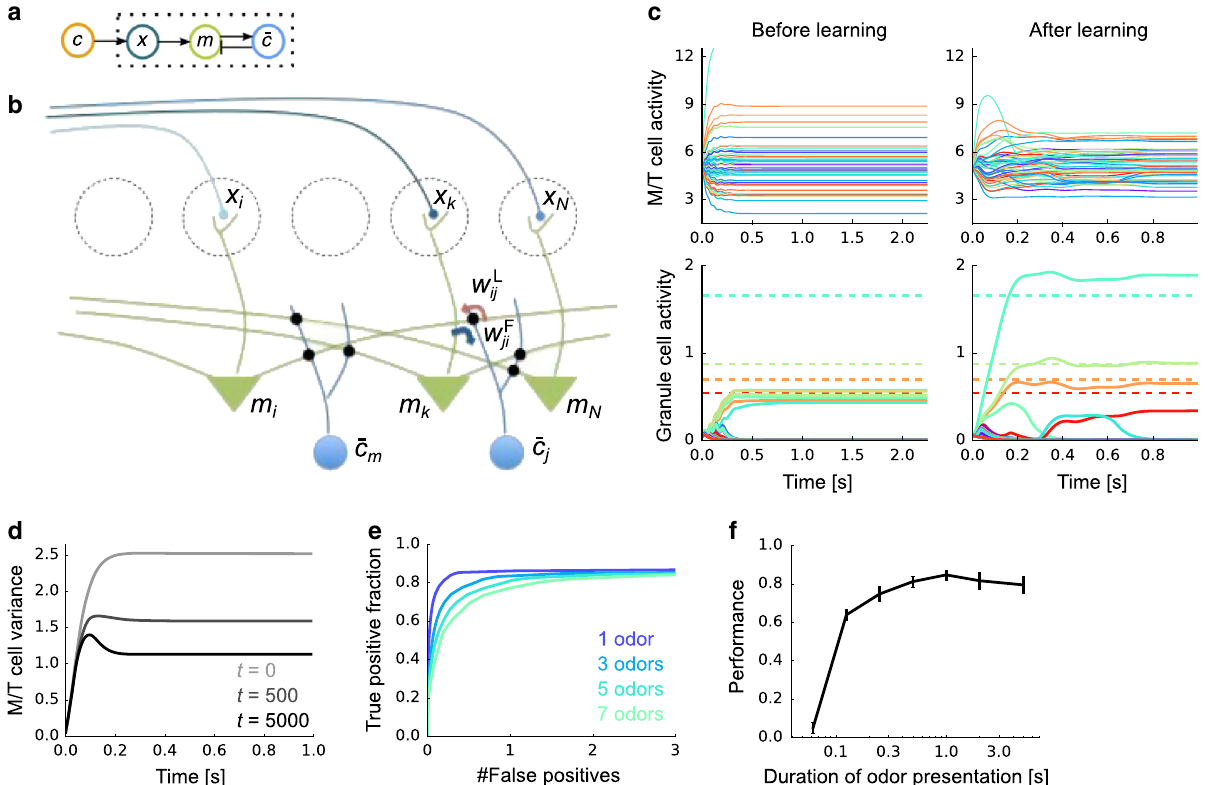
Fig. 3 Neural implementation of Bayesian learning. a Schematic of the neural architecture. Dotted box represents the internal variables of the brain; the odor, c , comes from the outside world. b The neural implementation of our Bayesian learning model maps almost perfectly onto the circuitry of the olfactory bulb. Dotted circles are glomeruli, green triangles are M/T cells, and blue circles represent olfactory granule cells. Red and blue arrows indicate weights from granule to M/T and M/T to granule cells, respectively. c An example of fi ring rate dynamics before (left) and after (right) learning ( M = 50 odors, N = 400 glomeruli, four odors presented). Different colors represent different neurons. Dotted horizontal lines in the bottom fi gures represent the true concentration of the presented odors. d Change in the variance of M/T cells during learning ( t : trial). The expectation was taken over both population and trials. e Receiver operating characteristic (ROC) curves under different numbers of simultaneously presented odors ( M = 100 odors, N = 400 glomeruli). See subsection “ ROC curve ” in the Methods section for details. f Performance under learning from various odor exposure duration (see subsection “ Performance evaluation ” in the Methods section), where M = 100, N = 400, and three odors are presented simultaneously, on average. The lines and their error bars are mean and standard deviation over 10